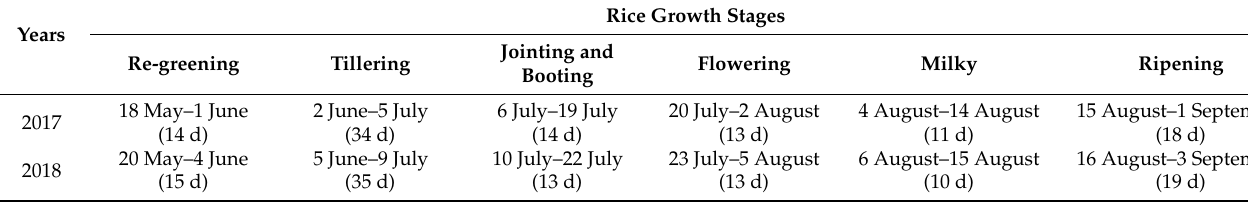
Table 1. Duration of different rice growth stages in 2017 and 2018.